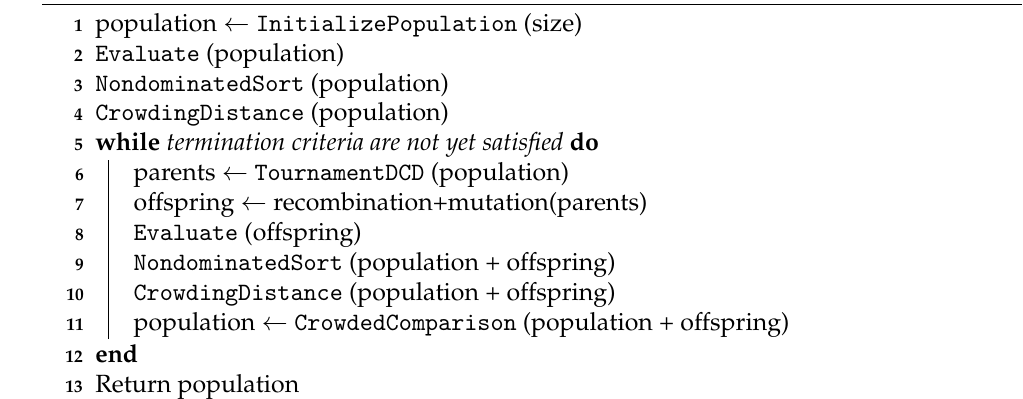
Algorithm 3: Nondominated Sorting Genetic Algorithm